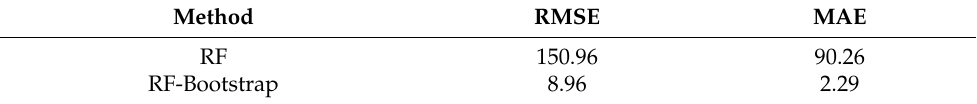
Table 1. Average RMSE values for Random Forest imputation methods coupled with Bootstrap